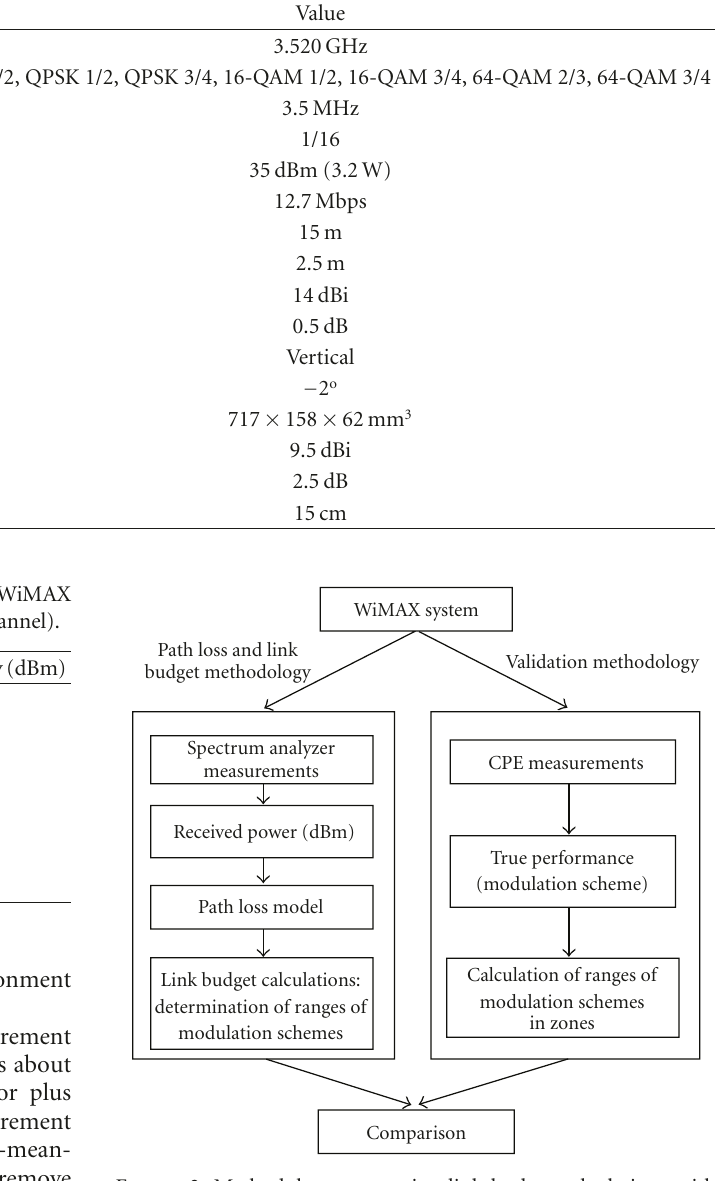
Figure 2: Methodology comparing link budget calculations with actual performance